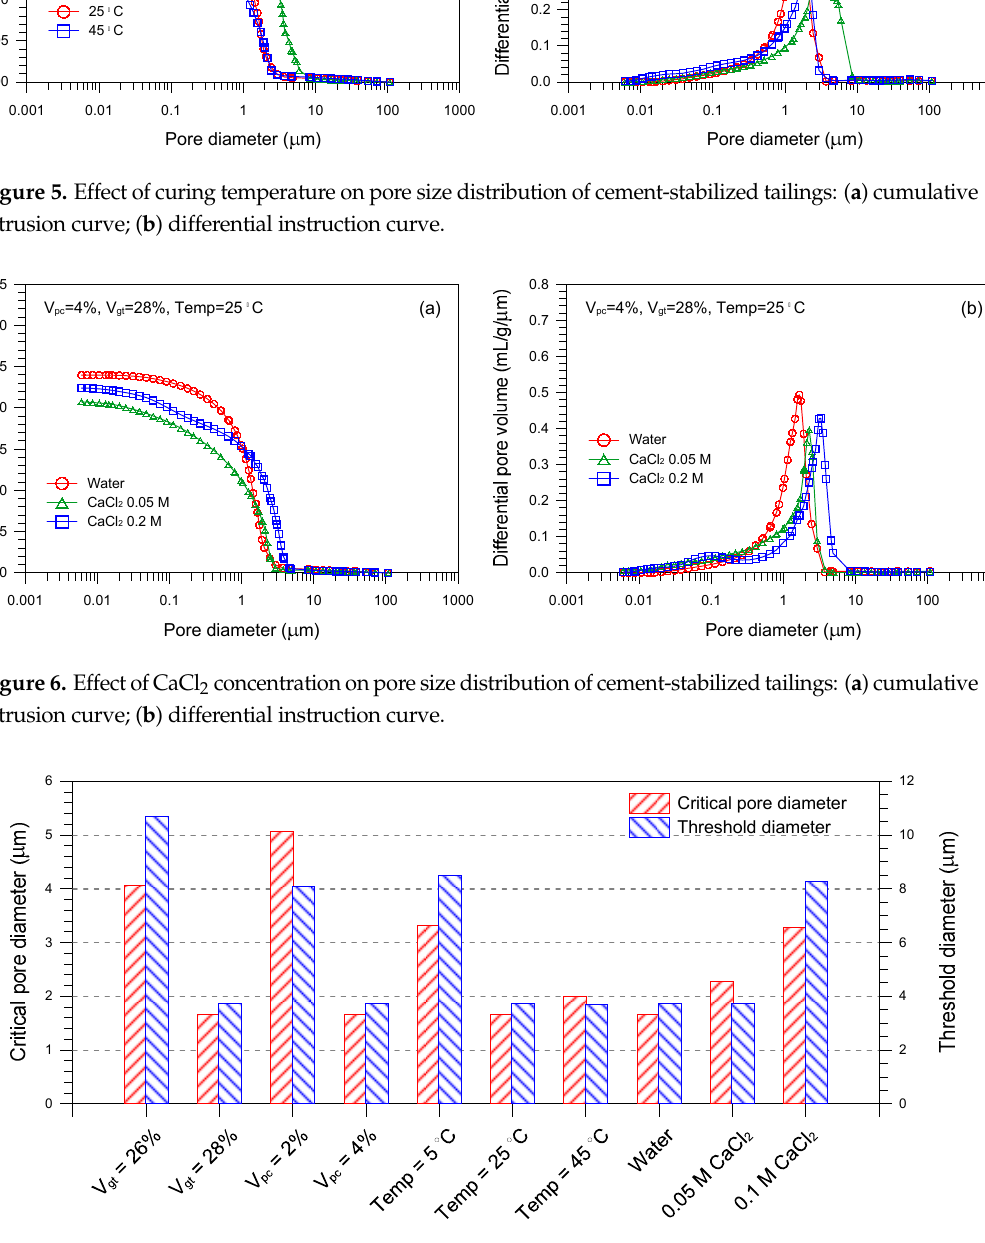
Figure 7. Critical pore diameter and threshold diameter of cement-stabilized tailings.